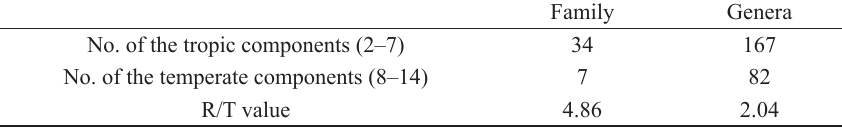
The R/T value of the areal types of aiSPS in China both at the family and genus